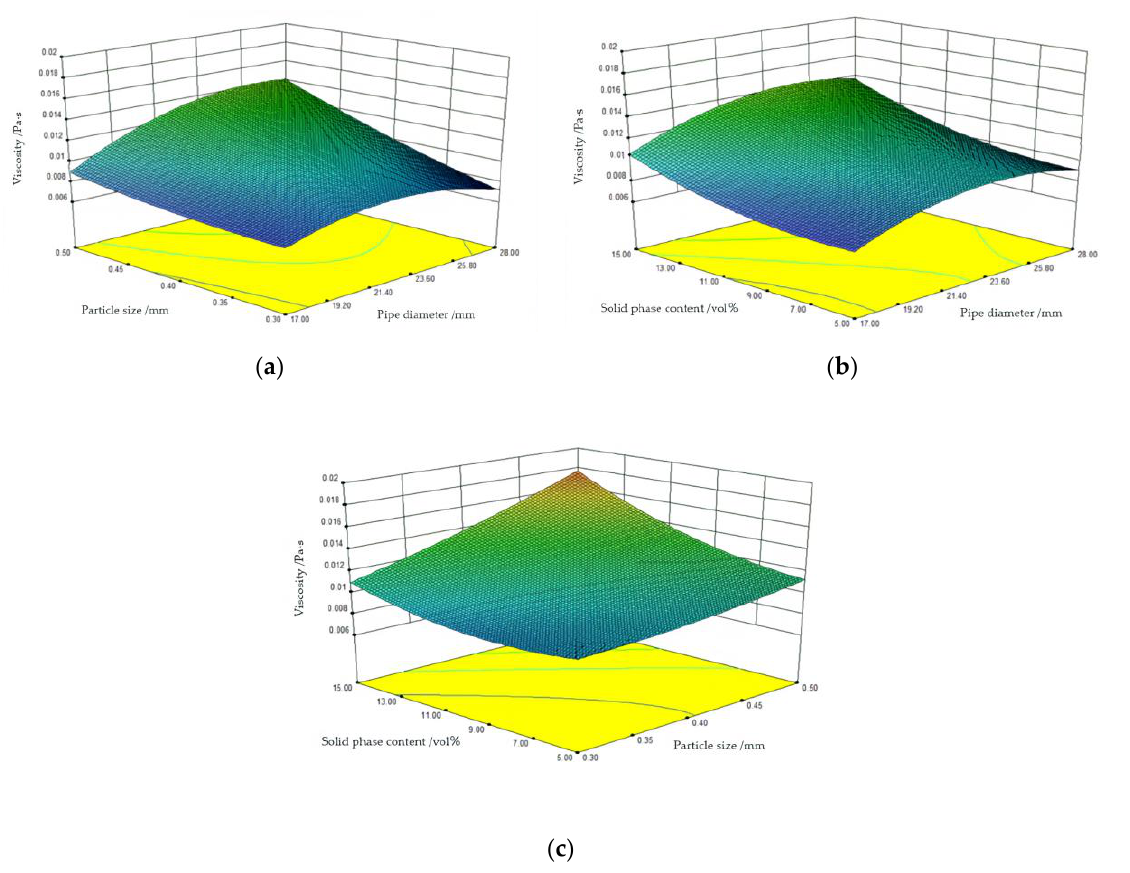
Figure 9. Response surface graphs of the interaction of three factors to yield stress. ( a ) The effect of pipe diameter and particle size on yield stress; ( b ) The effect of pipe diameter and solid content on yield stress; and ( c ) The effect of particle size and solid content on yield stress.